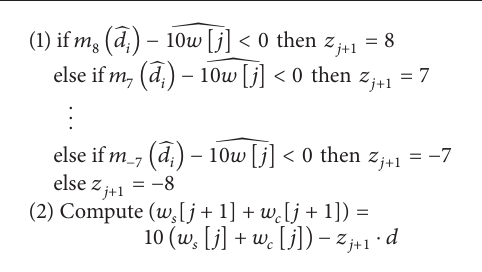
Algorithm 5: Pseudocode for the type3 digit